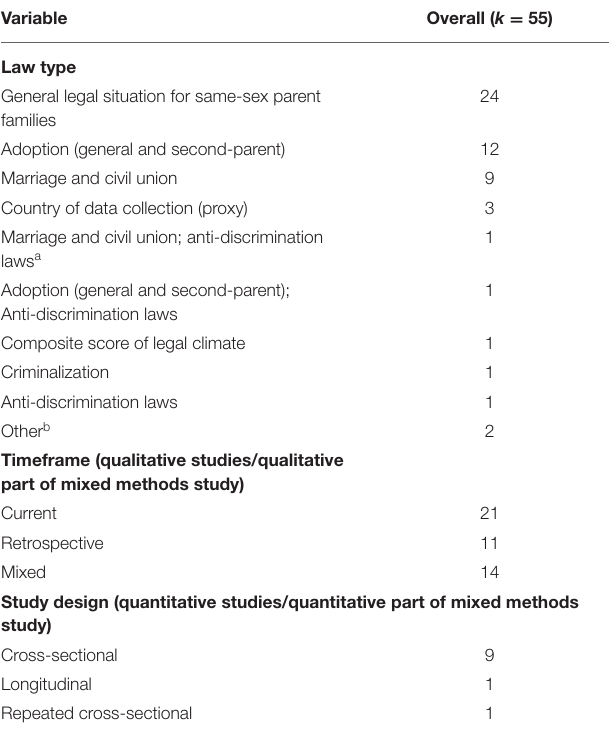
TABLE 3 | Study characteristics regarding investigated laws and